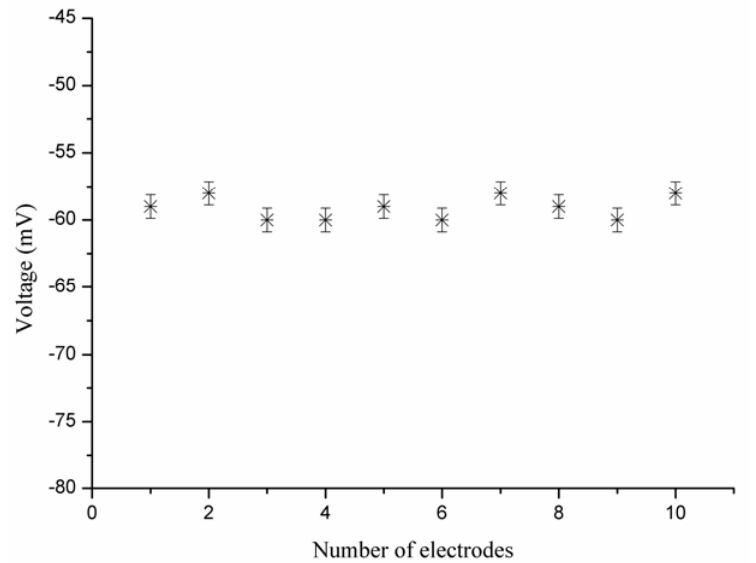
Figure 6. The reproducibility graph of the iodide ion sensor in the 5 × 10 − 4 M solutions of iodide